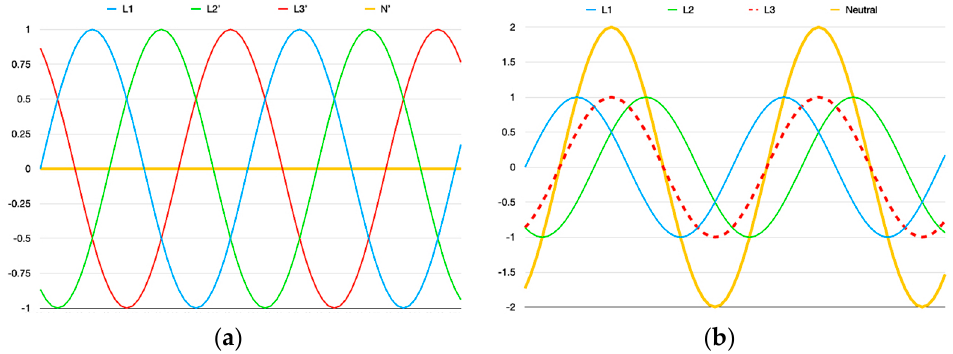
Figure 11. Balanced Y grid neutral current ( a ) and case in which in two phases energy is fed into the grid and in one phase energy is consumed from the grid ( b ).